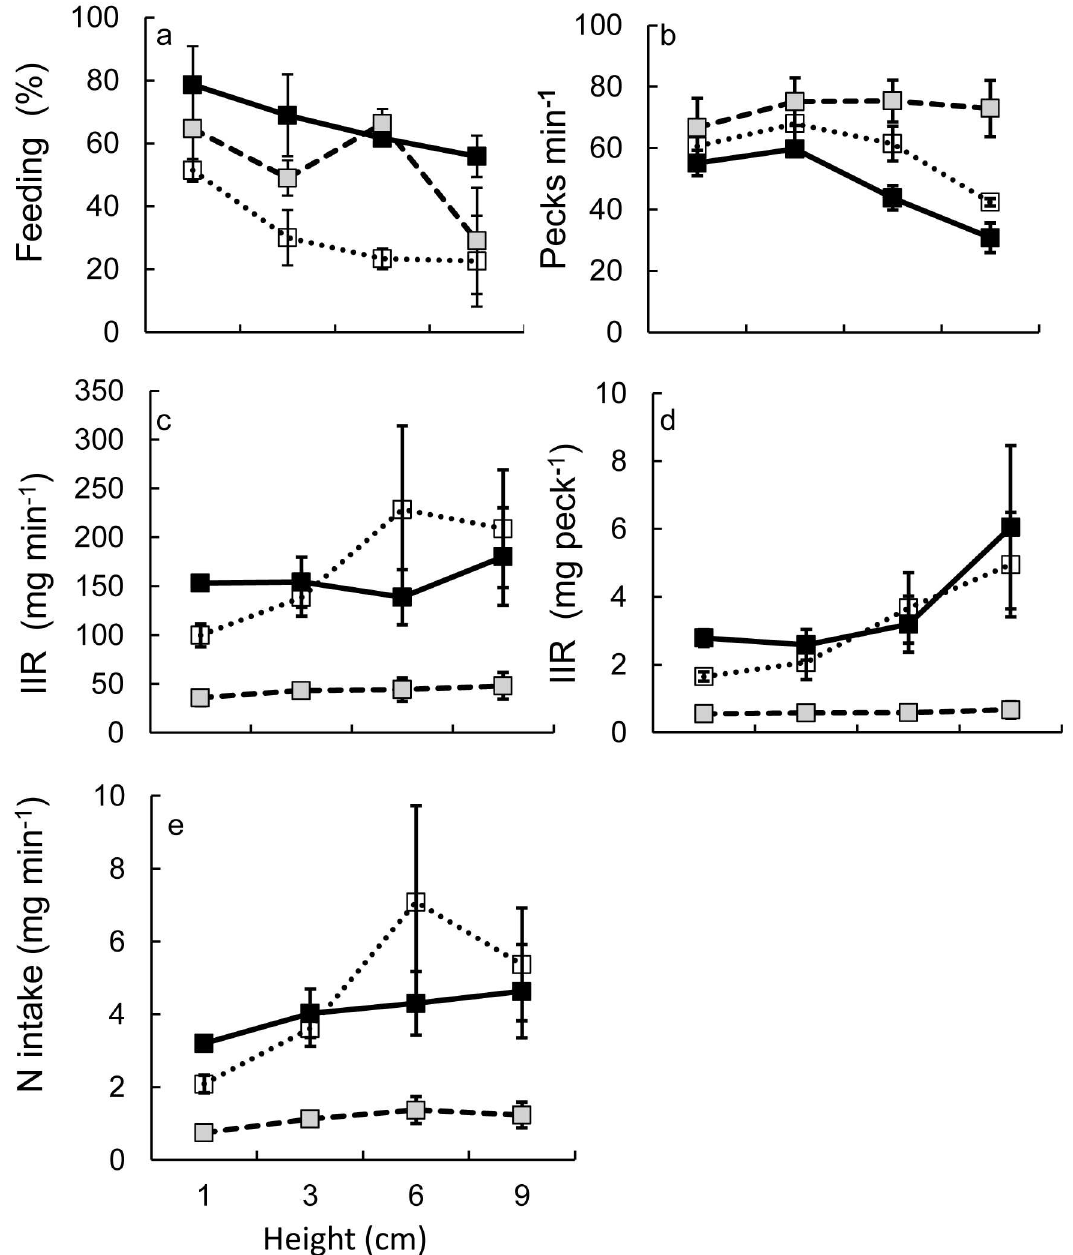
Fig 3. The relationship between sward height and feeding percentage (a), peck rate (b), instantaneous intake rate (IIR)(c and d) and nitrogen intake (e). Dark filled squares: swan goose; open squares: bean goose; grey filled squares: wigeon. The error bars show the ± 95%